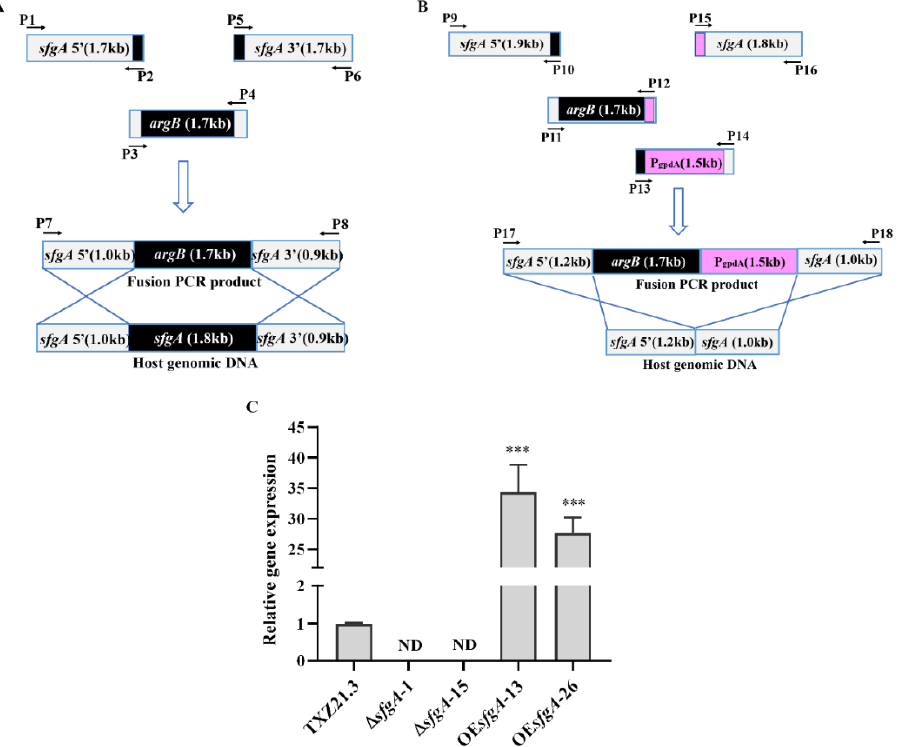
Figure 2. Generation of the ∆ sfgA and OE sfgA mutants in A. flavus . ( A , B ) The scheme of sfgA deletion and over-expression strategy, respectively . ( C ) qPCR analysis for the sfgA gene expression in Δ sfgA and OE sfgA strains. TXZ21.3 ( ∆ ku70 , ∆ argB , pyrG − ) is the transformation recipient strain. ND: not detected. *** p ≤ 0.001.